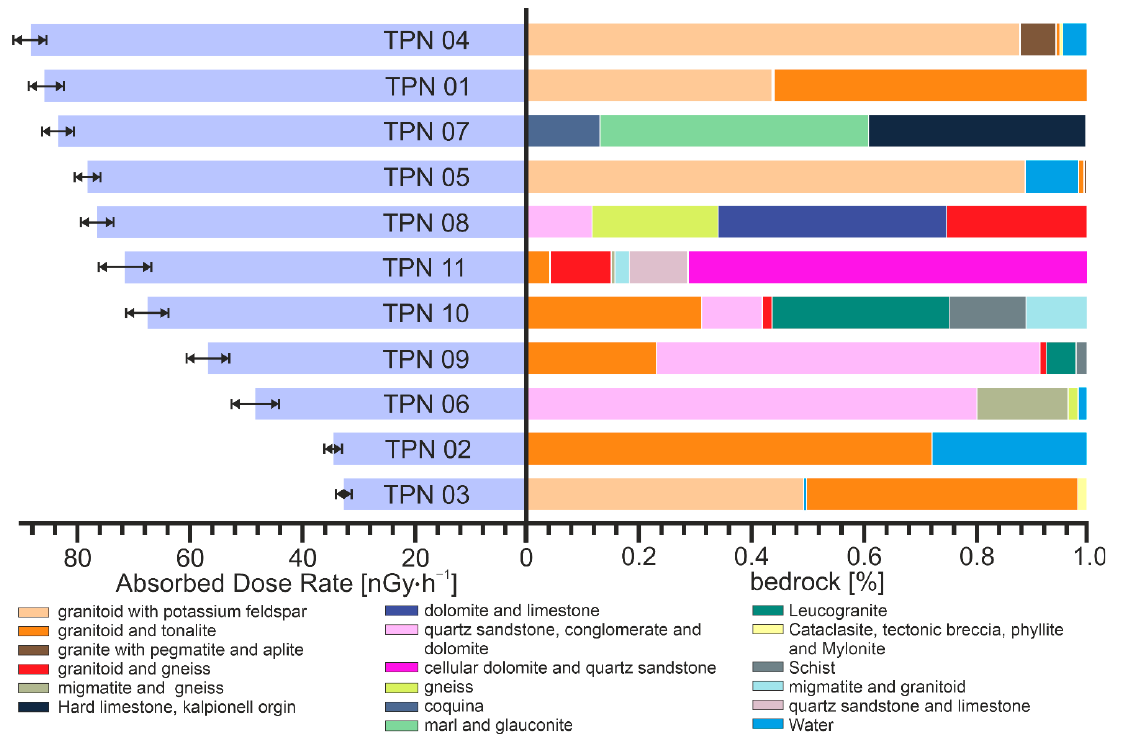
Figure 7. The ADR index for each point, along with a detailed illustration of the bedrock fractions. trend is observed in the spatial distribution in the area of the Tatra National Park.